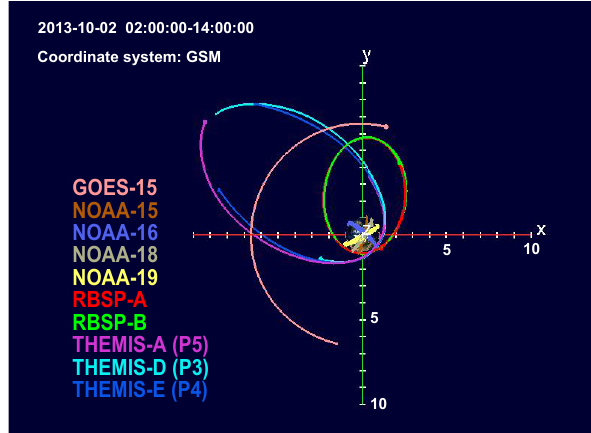
Figure 3. Satellite trajectories during 02:00–14:00UT on 2 October 2013 for four NOAA POES satellites, GOES-15, three innermost THEMIS probes (A, D, E), and two NASA Van Allen probes in the GSM x - y plane.